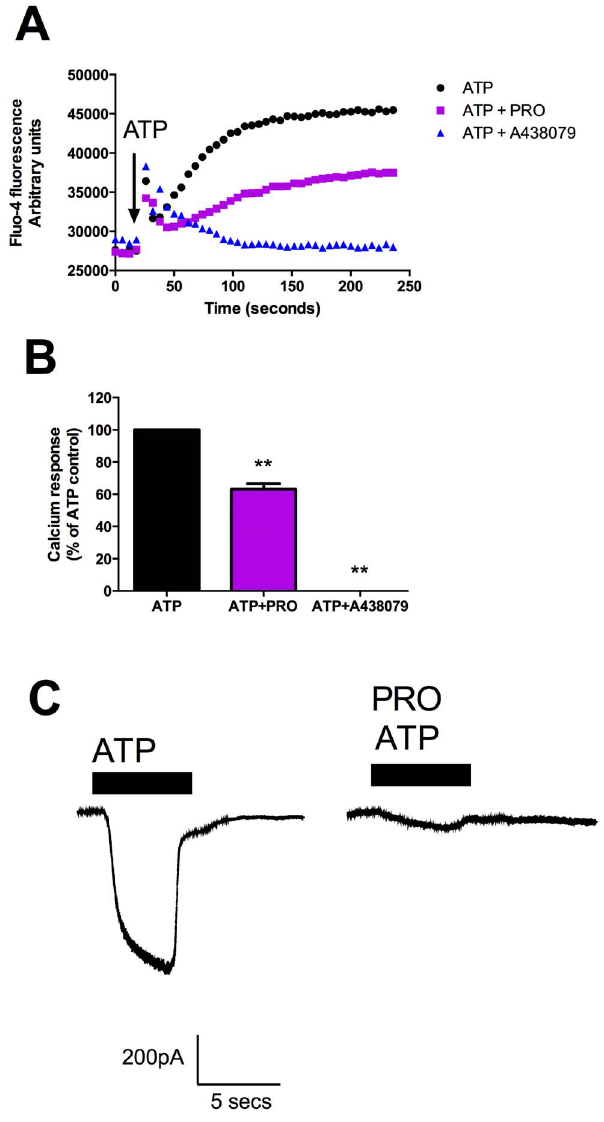
Figure 7. Probenecid blocks P2X7-mediated calcium influx and inward currents in HEK-hP2X7 cells. HEK-hP2X7 cells were loaded with 1 m M Fluo-4 for 30 minutes and calcium responses recorded at room temperature (26 u C) using a fluorescent plate reader. ATP (1 mM) was injected and fluorescence recorded at 520 nm in the absence of inhibitors or in the presence of 1 mM probenecid (purple) or 10 m M A- 438079 (blue). (B) Mean data from three independent calcium experiments. Sustained portion of the calcium response was measured and calculated as % of ATP control. Probenecid reduced response to 63 6 3.4% of control whereas A-438079 completely abolished the sustained calcium response. (C) Inward currents through wild-type human P2X7 receptors expressed in HEK-293 cells were recorded using whole cell patch clamp at room temperature. Membrane was clamped at 2 60 mV and ATP (1 mM in low divalent solution) was applied using a fast-flow delivery system. Black bars indicate ATP exposure (5 seconds). The initial ATP response was measured then the cell was exposed to probenecid for 2 minutes before re-challenge with ATP in the continued presence of probenecid. doi:10.1371/journal.pone.0093058.g007 IL-1 b [34]. P2X7 plays a key role in regulating activation of NLRP3 inflammasome by the danger signal ATP and the induction of rapid secretion of IL-1 b from monocytes and